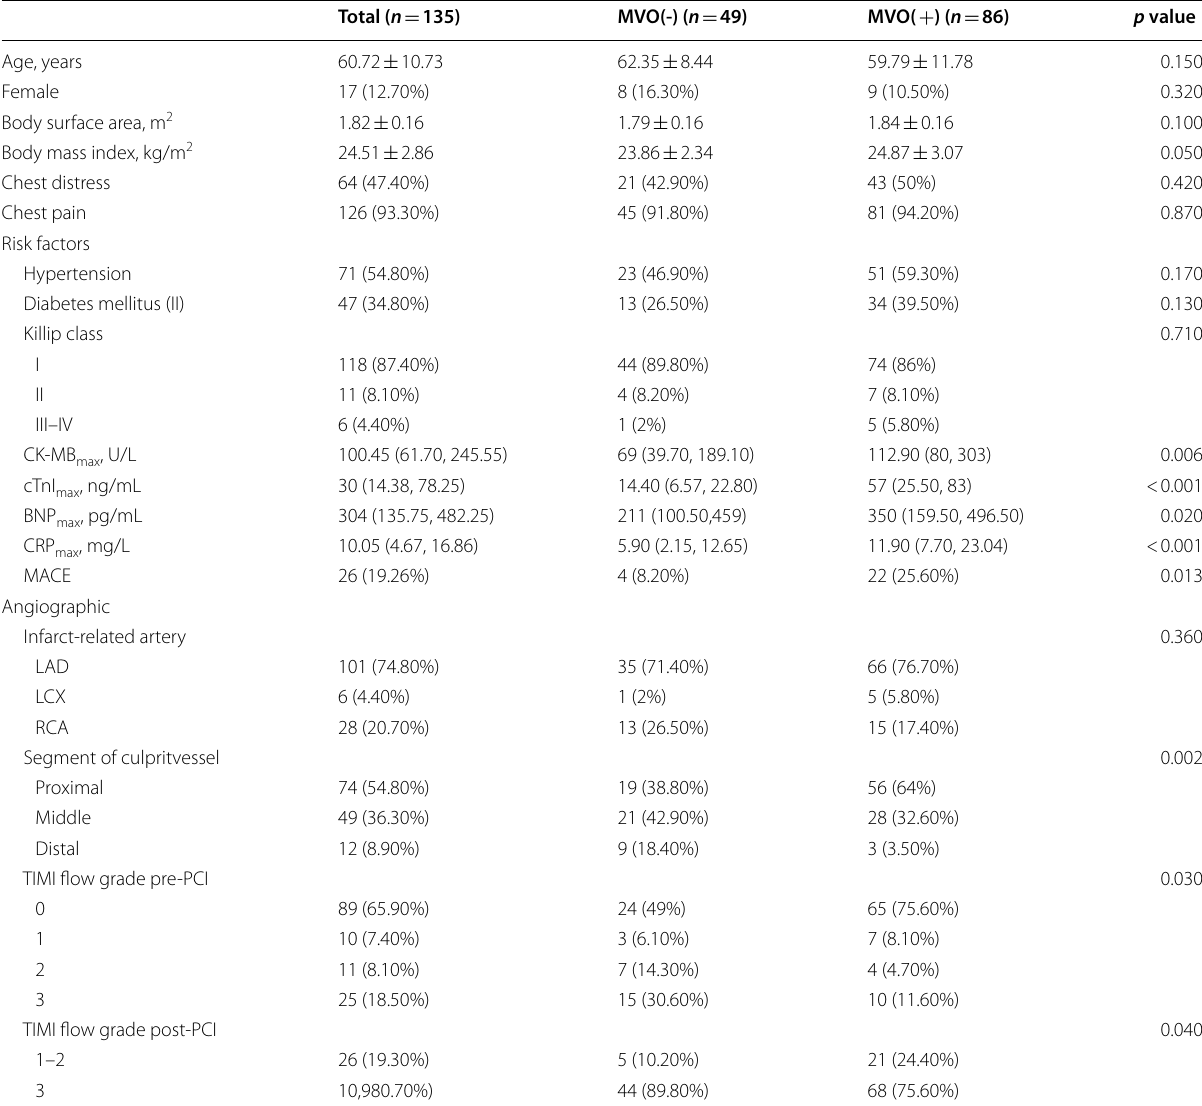
Table 1 Patients baseline